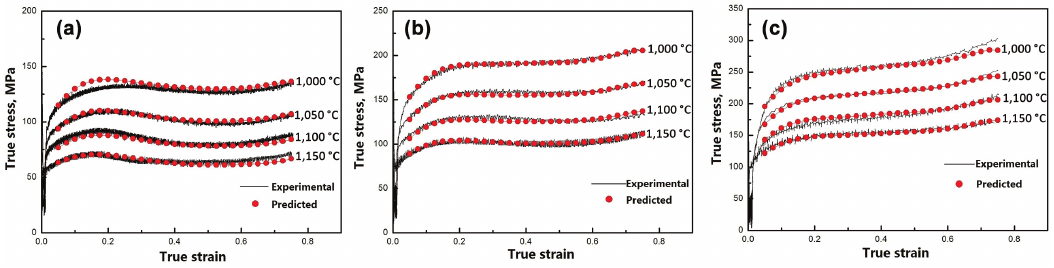
Figure 8: Comparison between predicted and experimental values at strain rates: (a) 0.01 s – 1 ; (b) 0.1 s – 1 ; and (c) 1 s – 1 .